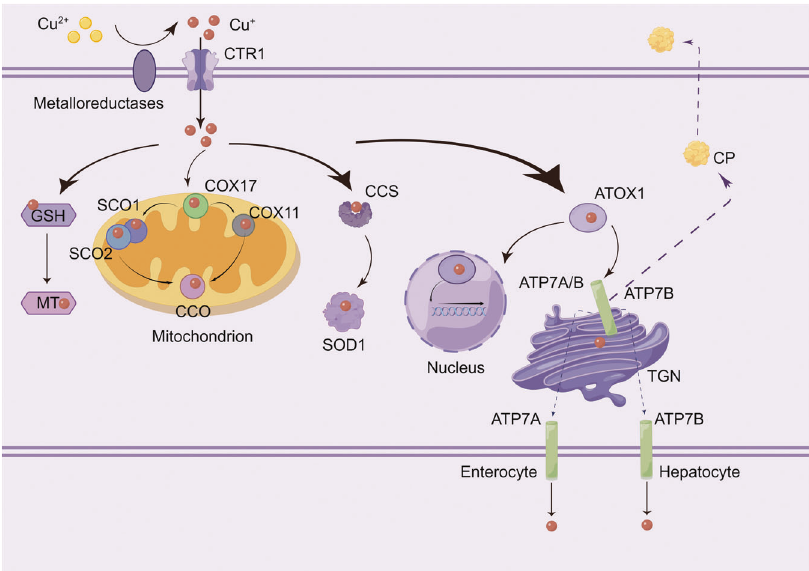
Fig. 1 Copper metabolism in mammals at a molecular level. Cu + can be sequestered by MT for storage. CTR1 is highly speci fi c for the uptake of Cu + . At physiologic Cu + levels, copper-transporting ATPases localize in the TGN, where they pump Cu + from the cytoplasm into the lumen of the TGN. When intracellular Cu + increases, these copper-transporting ATPases fuse with the plasma membrane to export Cu + . In the basolateral membrane of enterocytes, copper is pumped by ATP7A into the portal circulation and enters the main organ of copper storage, the liver. Excess copper in liver cells is secreted into bile in the form of vesicles via ATP7B. Cu + travels through the copper transport ATP7B-TGN pathway to form CP, which is then transported to various systems throughout the body. In addition, ATOX1 transports Cu + to the nucleus, where it binds to transcription factors and drives gene expression. COX17 transports Cu + to the copper-carrying proteins SCO1, SCO2, and COX11 and delivers it to CCO to activate the activity of enzymes in the respiratory chain. CCS can transfer Cu + to SOD1. ATOX1 antioxidant-1,